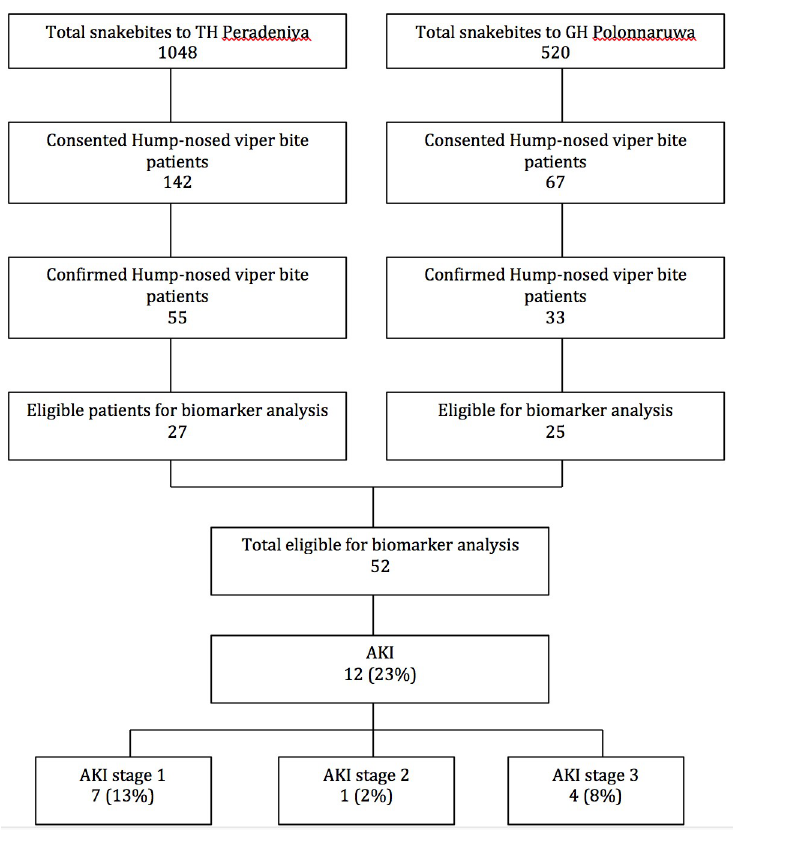
Fig 1. Flow chart of included patients and grading of acute kidney